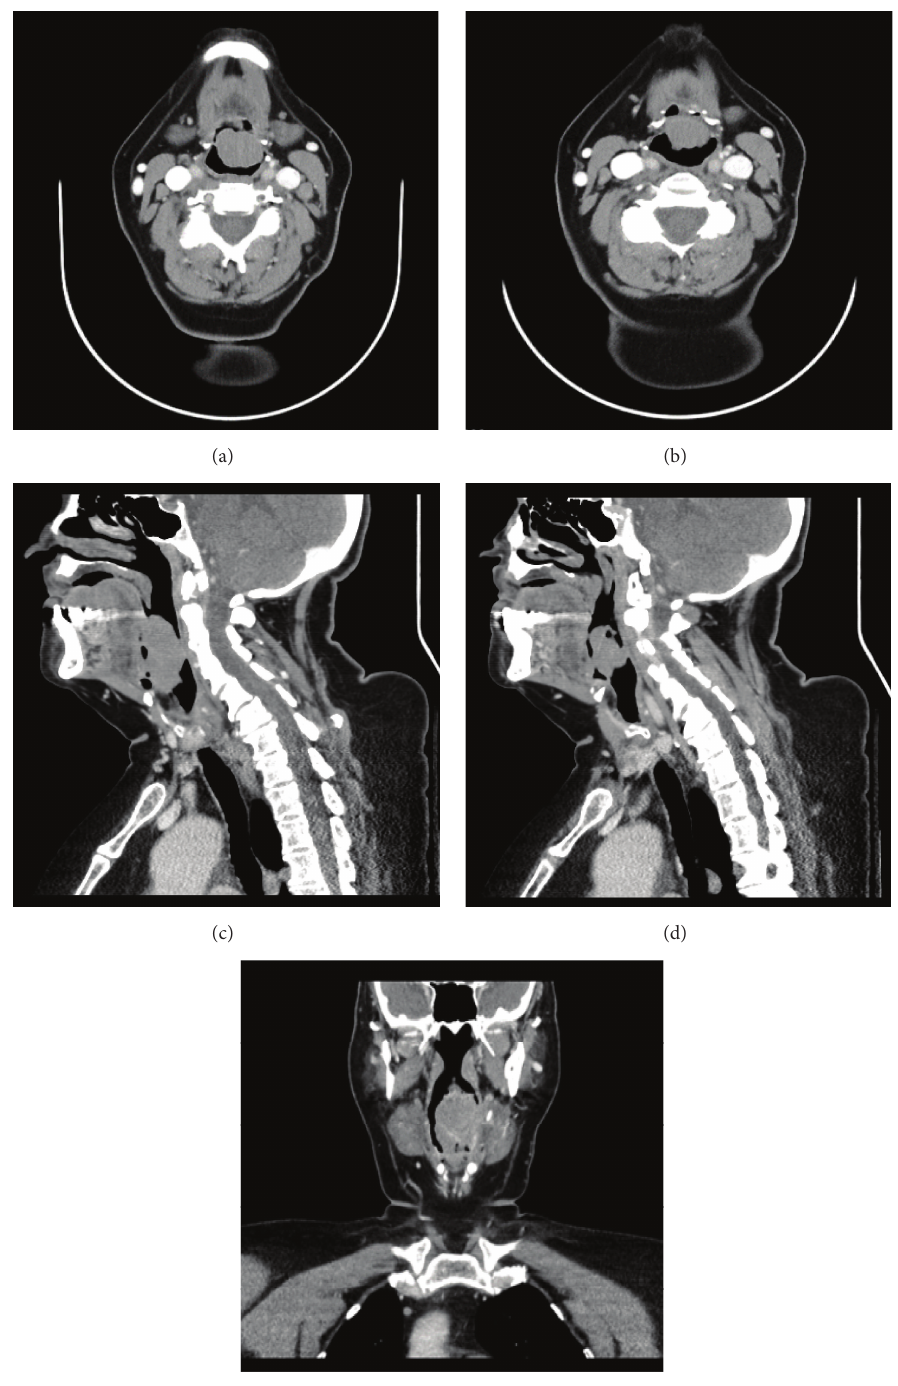
Figure 1: Axial CT neck (a and b), sagittal CT neck (c and d), and coronal CT neck (e), with contrast, show the anteriorly sessile soft tissue mass arising from the laryngeal surface of epiglottis, with relatively stable position. The epiglottis has no submucosal extension.